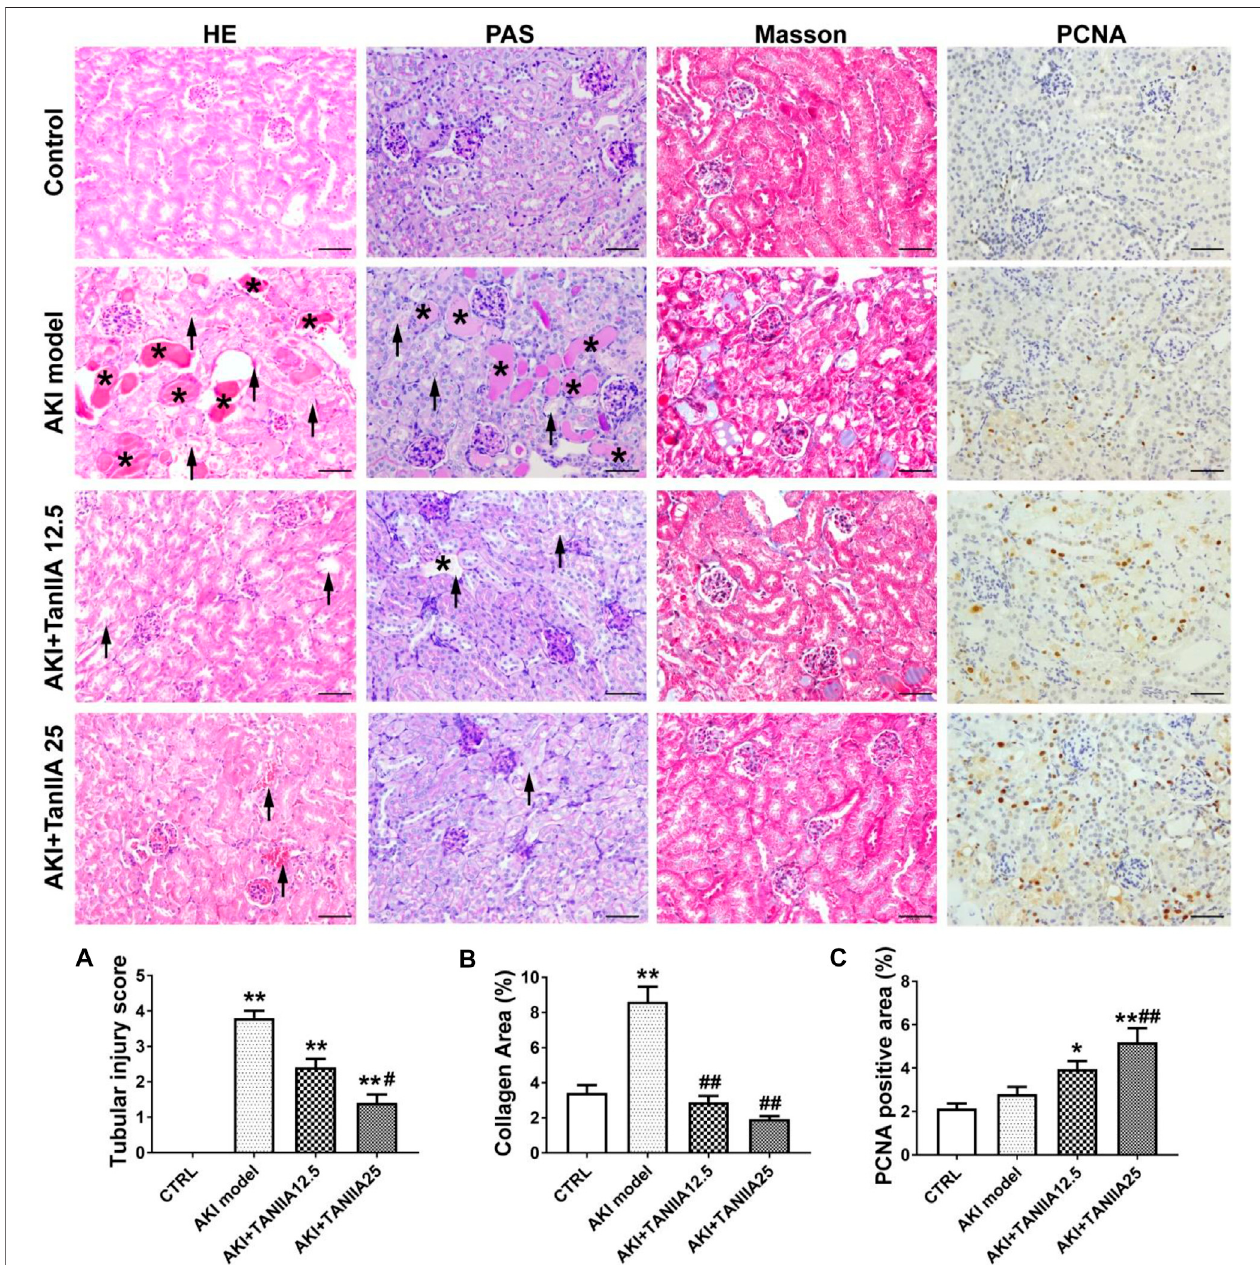
FIGURE3| TanIIAimprovesrenalfunctionbypreventingcellnecrosisandpromotingproliferation. (A,B) RepresentativeimagesandrelativequantitativedataofHE, PAS, and Masson ’ s trichrome staining in mouse kidney sections. The AKI model group observed tubular necrosis (arrowheads) and casts (asterisks). (C) Immunohistochemical staining of PCNA in indicated groups. Data represent as mean ± SEM, *p < 0.05, **p < 0.01 compared with the control group ( n = 5). #p < 0.05, ##p < 0.01 compared with AKI group ( n = 5). One-way ANOVA followed by Turkey ’ s test for multiple comparisons was used for three or more groups. Scale bar, 50 μ m; abbreviations: PCNA, proliferating cell nuclear